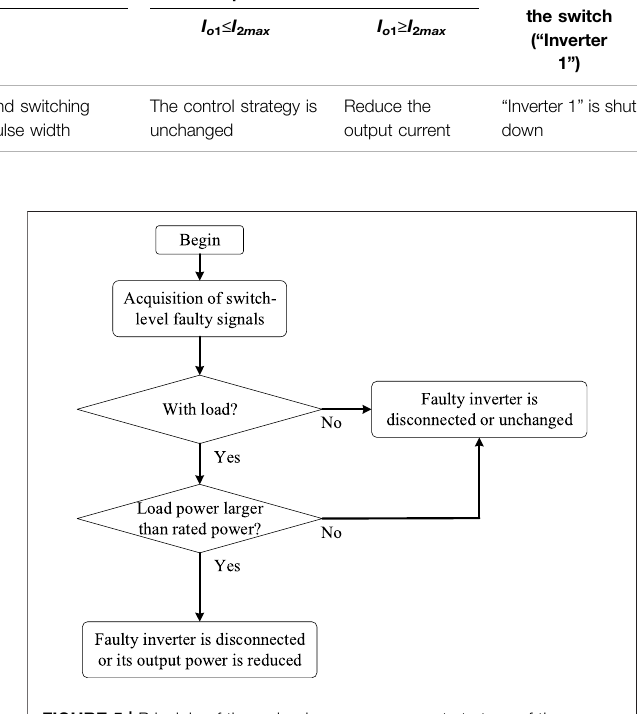
FIGURE 5 | Principle of the redundancy management strategy of the system